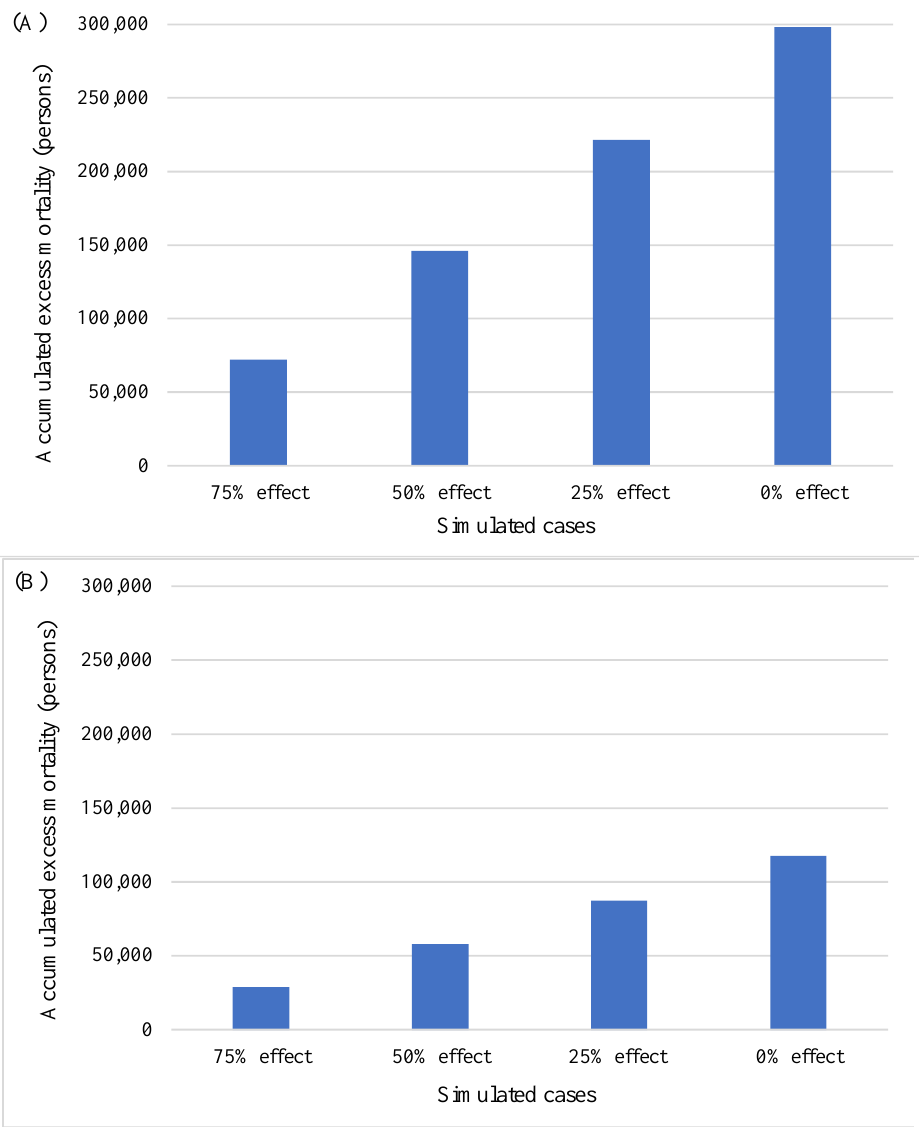
Figure 6. Accumulated excess cardiovascular mortality (number of persons) between 1950 and 2017. ( A ) Men and ( B ) women: 75% effect, 75% of the actual effect of salt-intake reduction; 50% effect, 50% of the actual effect of salt-intake reduction; 25% effect, 25% of the actual effect of salt-intake reduction; 0% effect, no effect of salt-intake reduction since 1950.